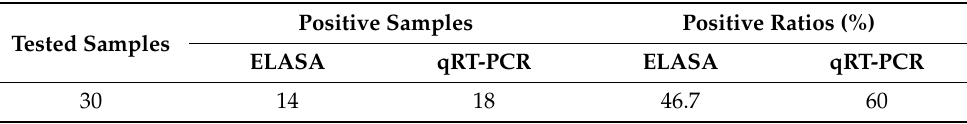
Table 2. Sensitivity comparison of sandwich ELASA and qRT-PCR for detection of 30